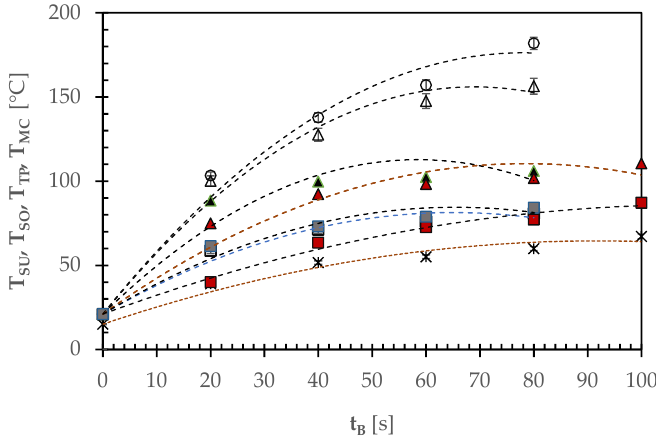
Figure 5. Time course of the average temperature of the upper area as a whole (T SU ) or segmented with the two or three ingredients used to garnish the pizza samples examined in this work: A, ; B, ; C, (cid:3) ; D: T TP , (cid:4) ; T SO , (cid:78) ; E: T TP , (cid:3) ; T SO , (cid:52) ; T MC , ∗ ), where T TP , T SO , or T MC is the temperature of the pizza surface area garnished with tomato puree, sunflower oil, or mozzarella cheese, respectively. The broken lines refer to the quadratic regression lines used to simulate the different temperature profiles.